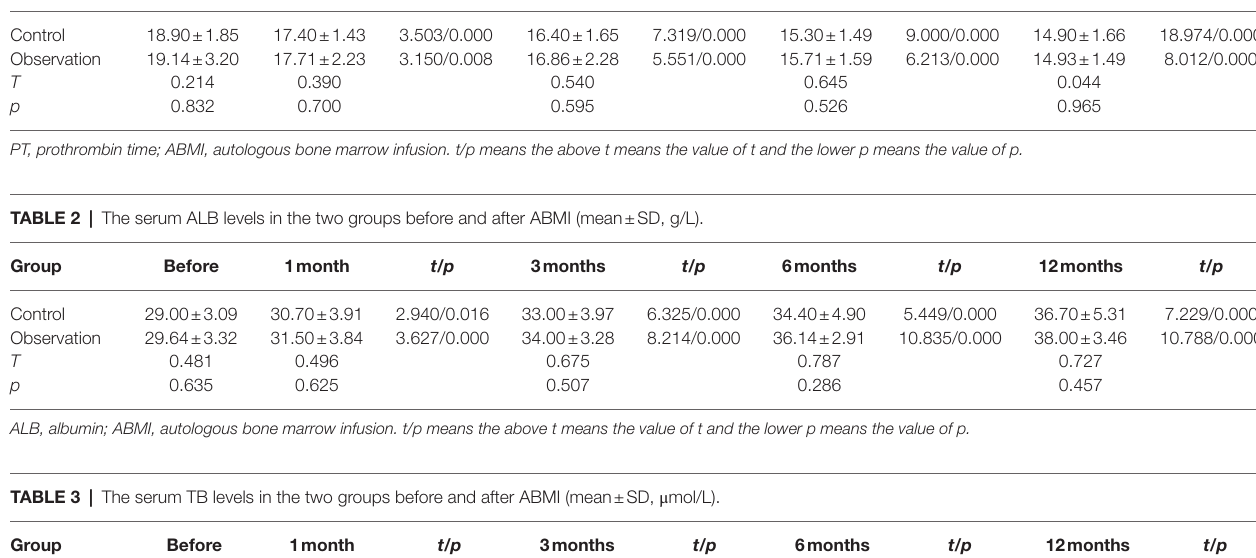
TABLE 1 | The prothrombin time (PT) in the two groups before and after autologous bone marrow cell infusion (ABMI; mean ± SD, s). Group Before 1 month t/p